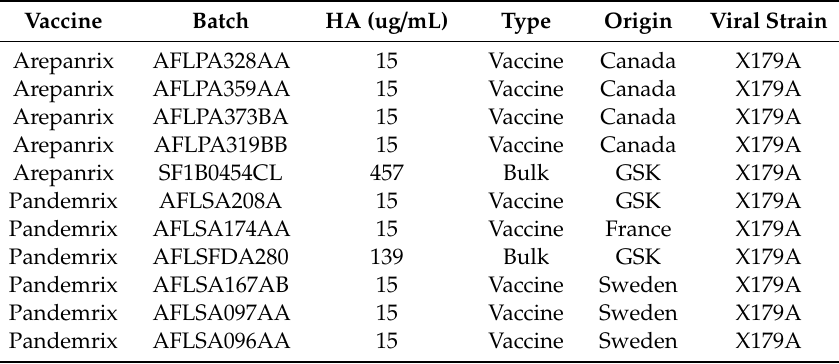
Characteristics of Pandemrix and Arepanrix lots used in the Mass Spectrometry (MS)